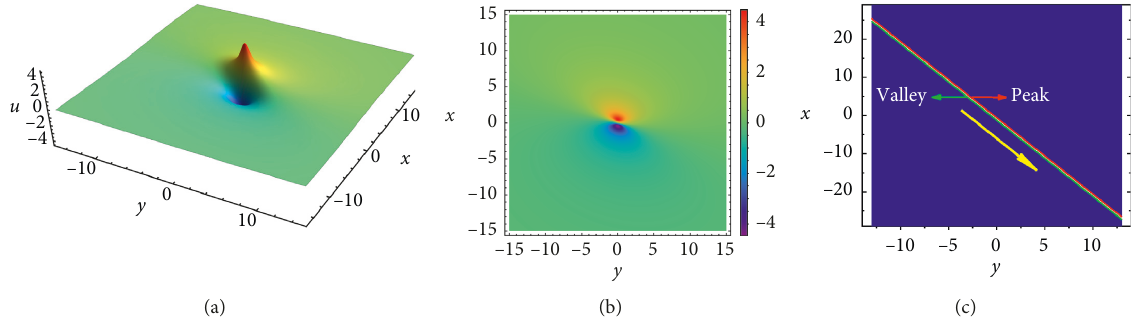
Figure 1: (a) The three-dimensional plot of the nonautonomous lump wave via the solution (9). (b) The density plot of (a). (c) The line-typed trajectory of the nonautonomous lump wave via the solution (9). The relevant parameters are set to a